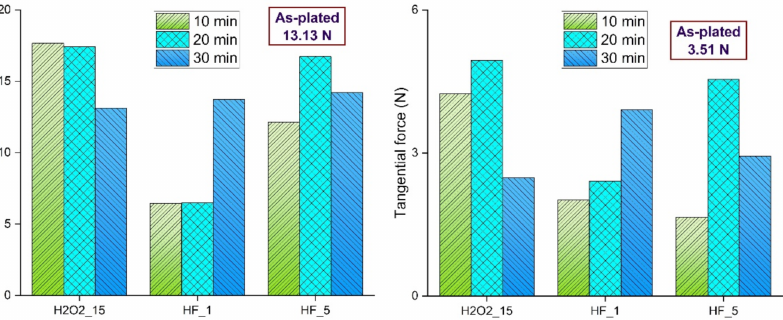
Figure 16. Normal and tangential forces during MRF of as-plated and chemically treated